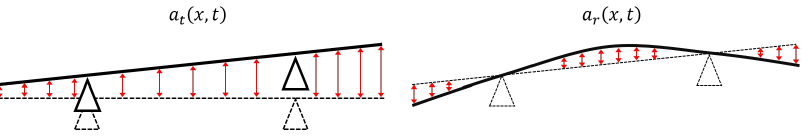
Figure 15. Components of the total base acceleration which excites the PE cantilever